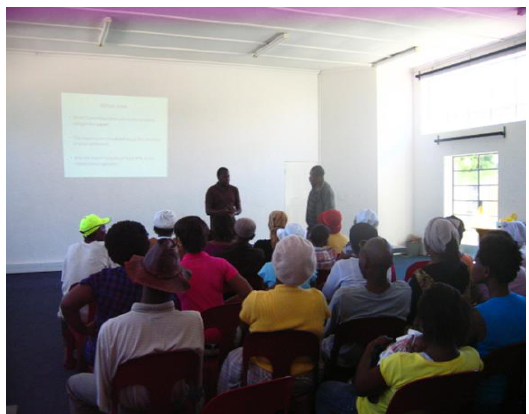
Figure 3. Validating the data with the community